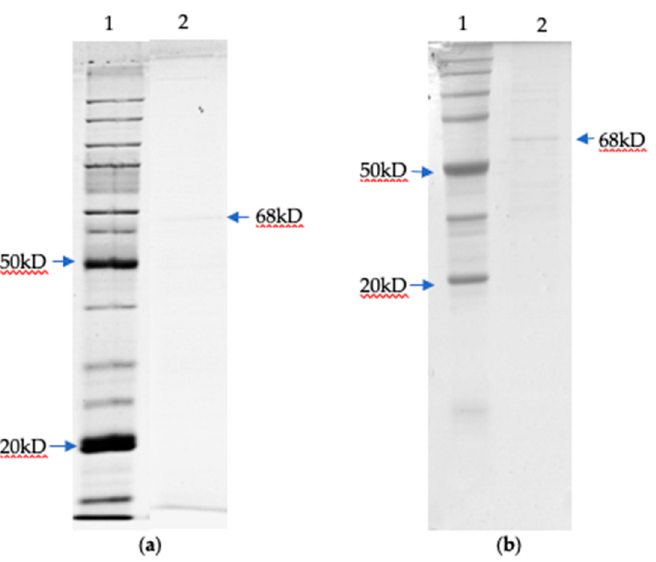
Figure 3. This figure shows 12% Sodium Dodecyl Sulfate Polyacrylamide Gel Electrophoresis of ( a ) Antarctic α -amylase from Pseudogymnoascus sp. stained in Coomassie Blue. (Lane 1: Invitrogen BenchMark Protein marker, Lane 2: Partially purified α -amylase from Pseudogymnoascus sp. from the Antarctic); ( b ) Arctic α -amylase from Pseudogymnoascus sp. stained in Coomassie Blue. (Lane 1: Invit- rogen BenchMark Protein marker, Lane 2: Partially purified α -amylase from Pseudogymnoascus sp. from the